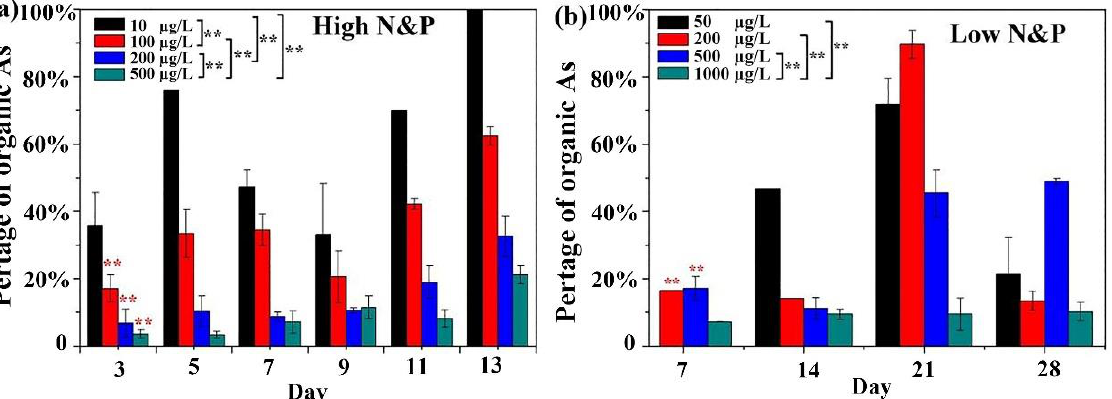
Figure 7. The intracellular and extracellular DMA(V) concentrations varied with incubation time that exposed different iAs(V) concentrations in the high ( a ) and low ( b ) nutrient sets. Note: Red and black * on the legend indicate significant variations of intracellular and extracellular DMA(V) concentrations with incubation time, respectively, between each of two groups of ambient iAs(V) concentrations; blue * indicates significant variations between intracellular and extracellular DMA(V) concentrations in four groups of ambient iAs(V) concentrations. Red, black, and blue * on column bars indicate significant variations of intracellular, extracellular, and total DMA(V) concentration with incubation time. Significance levels below 0.05 (*) and 0.01 (**) are denoted in the figure.